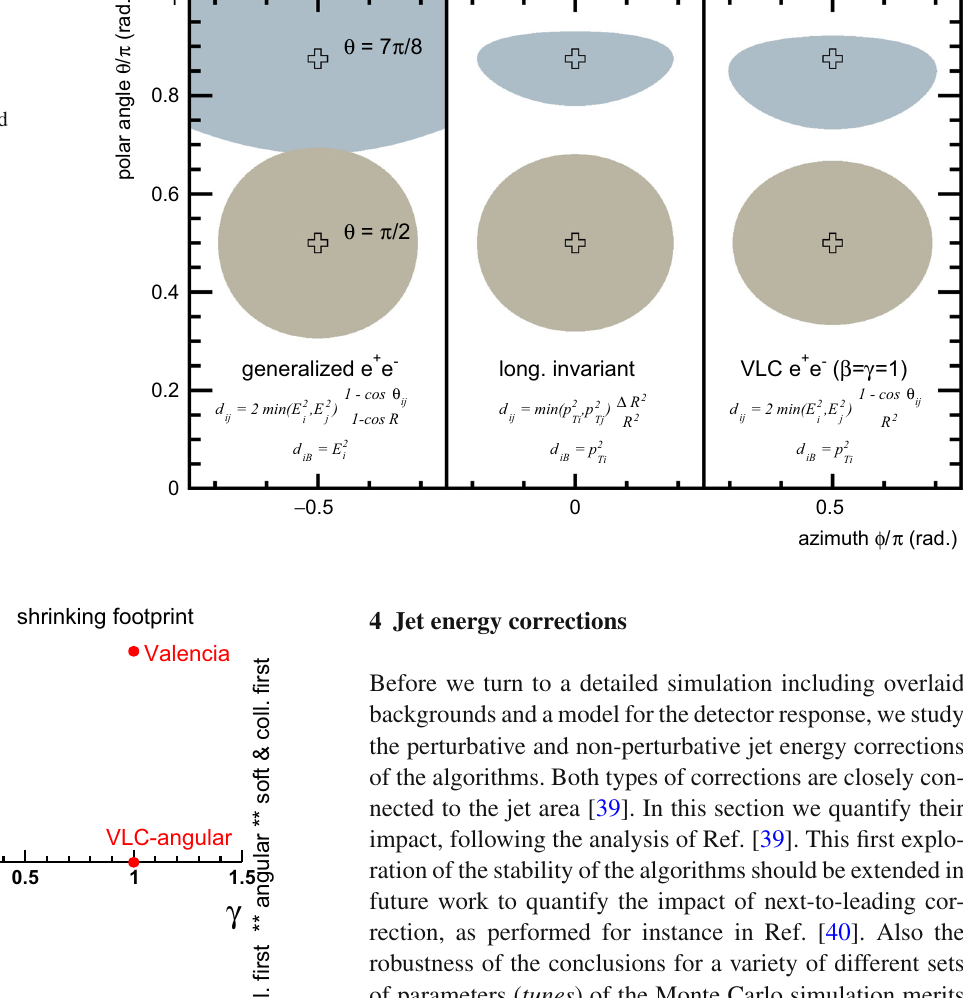
Fig. 3 The area or footprint of jets reconstructed with R = 0.5 with the three major families of sequential recombination